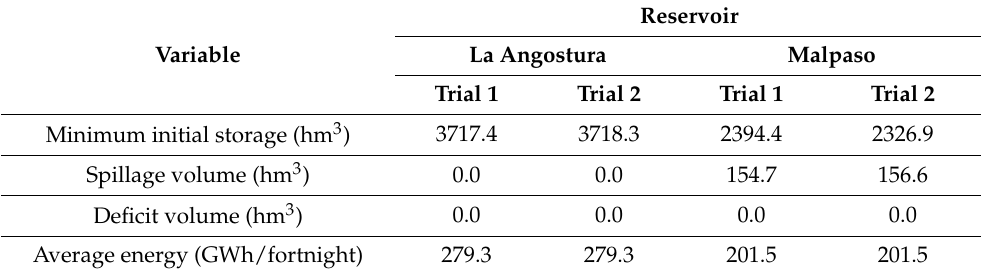
Table 2. Simulation